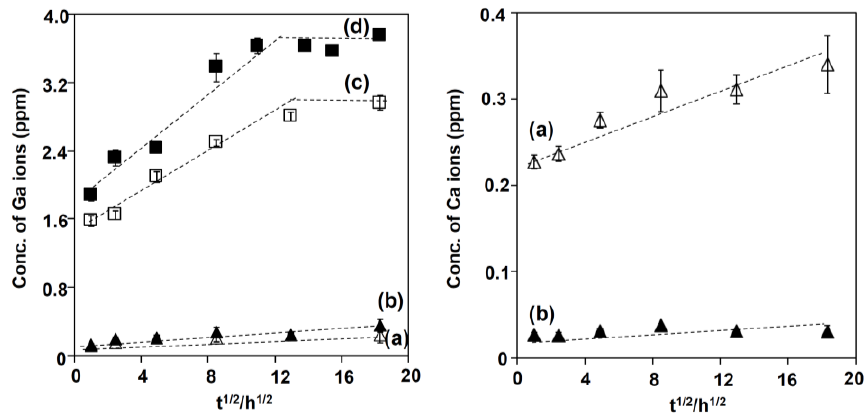
Figure 6. Concentrations of Ga and Ca ions measured by ICP (inductively coupled plasma emission spectroscopy), which was released from Ti subjected to ( a ) NaOH; 100Ca + 0.05Ga and heat treatment, and subsequent ( b ) water treatment; or ( c ) NaOH, 100Ga and heat treatment, and subsequent ( d ) water treatment as a function of square root of soaking time in PBS.